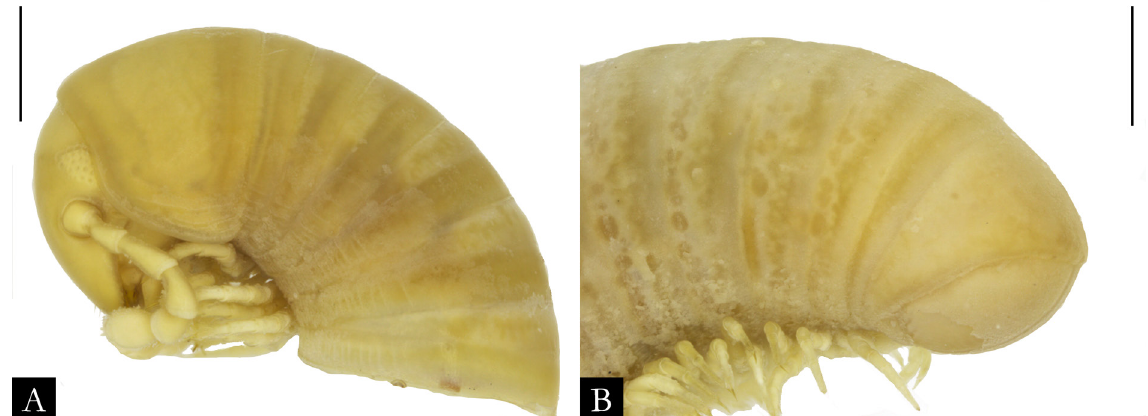
Fig. 51. Pseudonannolene bovei Silvestri, 1895, syntype, ♂ (MCSN), in lateral view. A . Anterior region. B . Posterior region. Scale bars = 1